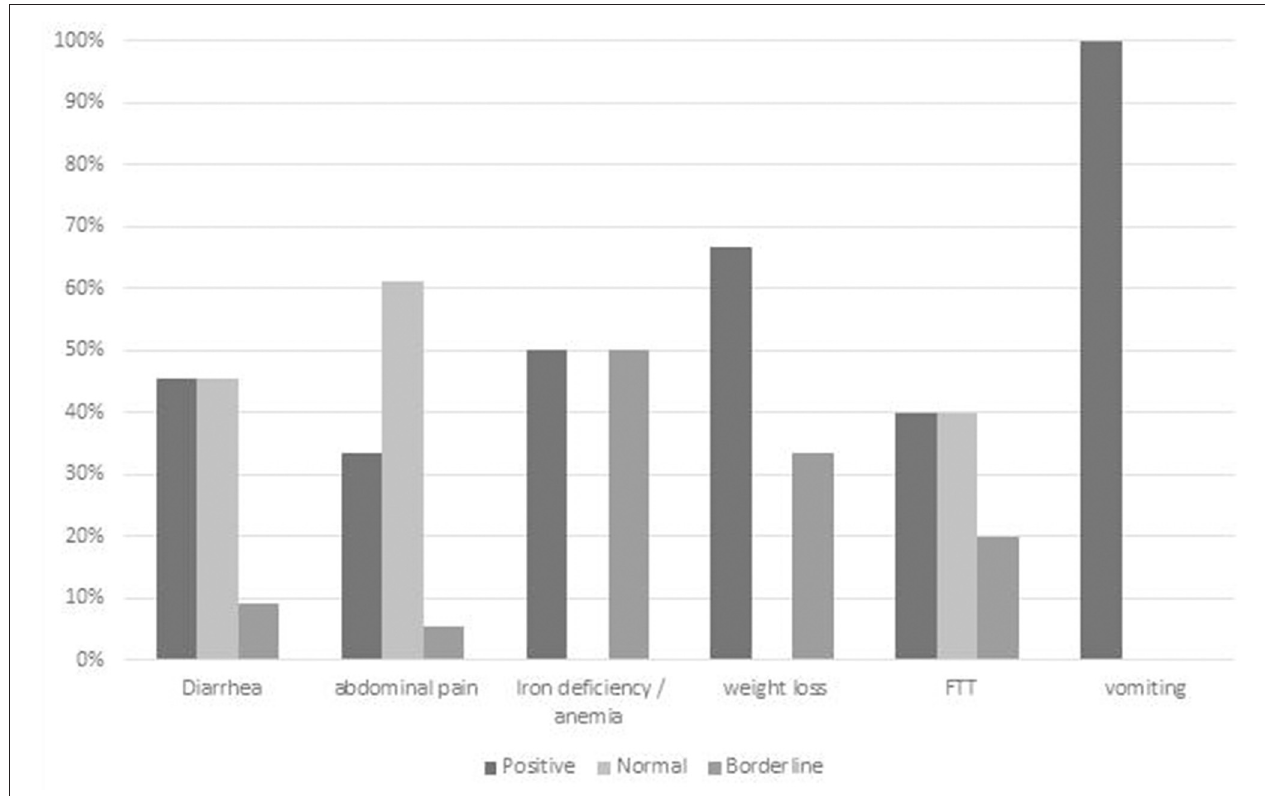
FIGURE 4 | Diagnostic yield of GIE in subgroup analysis of chronic diarrhea with different joint referral indications. Positive = definite diagnostic finding relating to indication; Borderline = finding of uncertain relationship to indication or minor finding of uncertain significance; Negative = no finding or incidental finding unrelated to indication. IDA, iron deficiency anemia; FTT, failure to